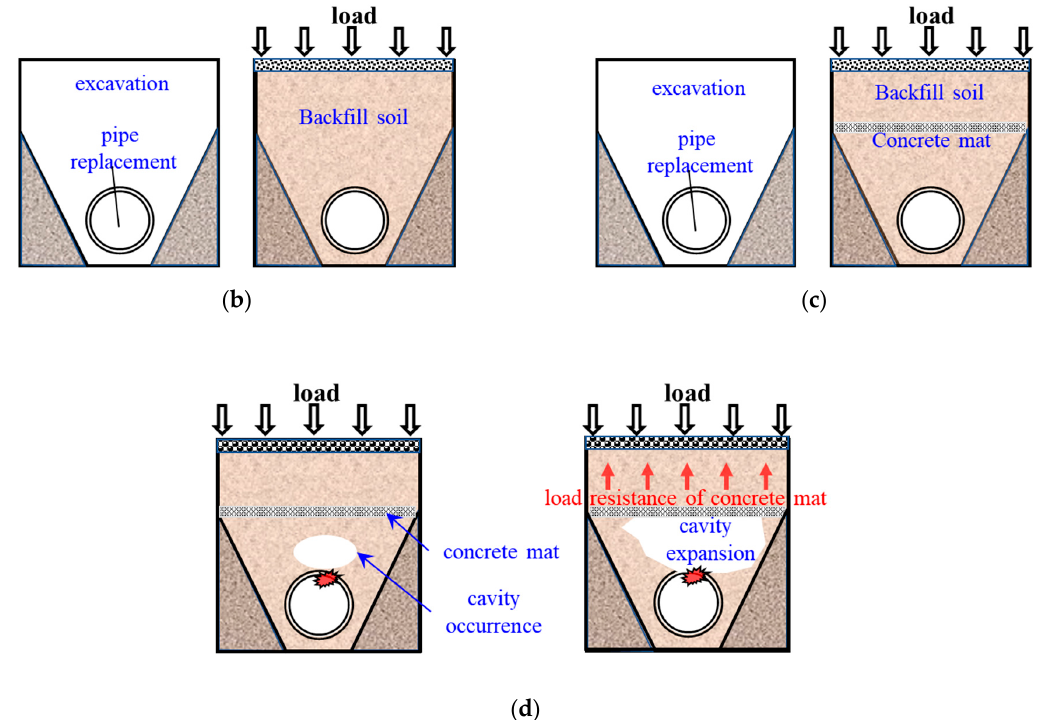
Figure 2. Schematic of the ground subsidence restoration and the ground reinforcement using a concrete mat: ( a ) process of ground subsidence occurrence due to an underground cavity; ( b ) typical restoration method employed for ground subsidence occurrence; ( c ) restoration method using a concrete mat for ground subsidence occurrence; ( d ) role of the concrete mat in underground cavity occurrence.